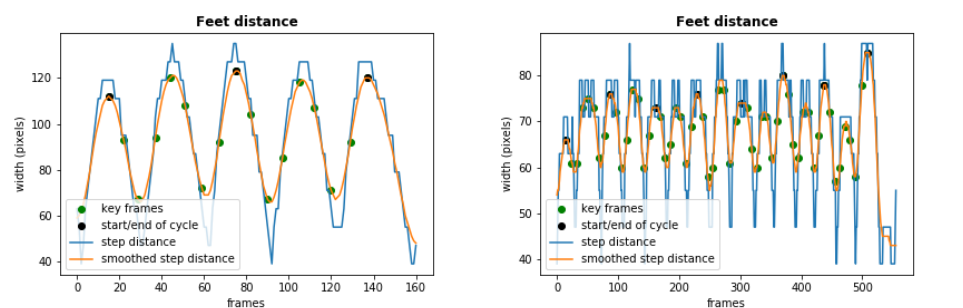
Figure 3. Feet distance plot along the frames highlighting the extracted 9 key frames in a normal gait sequence ( left ) and a Parkinsonian gait sequence ( right